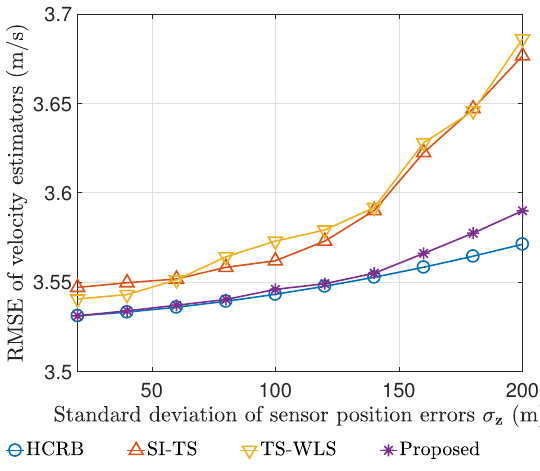
Figure 4. RMSE and HCRB for velocity